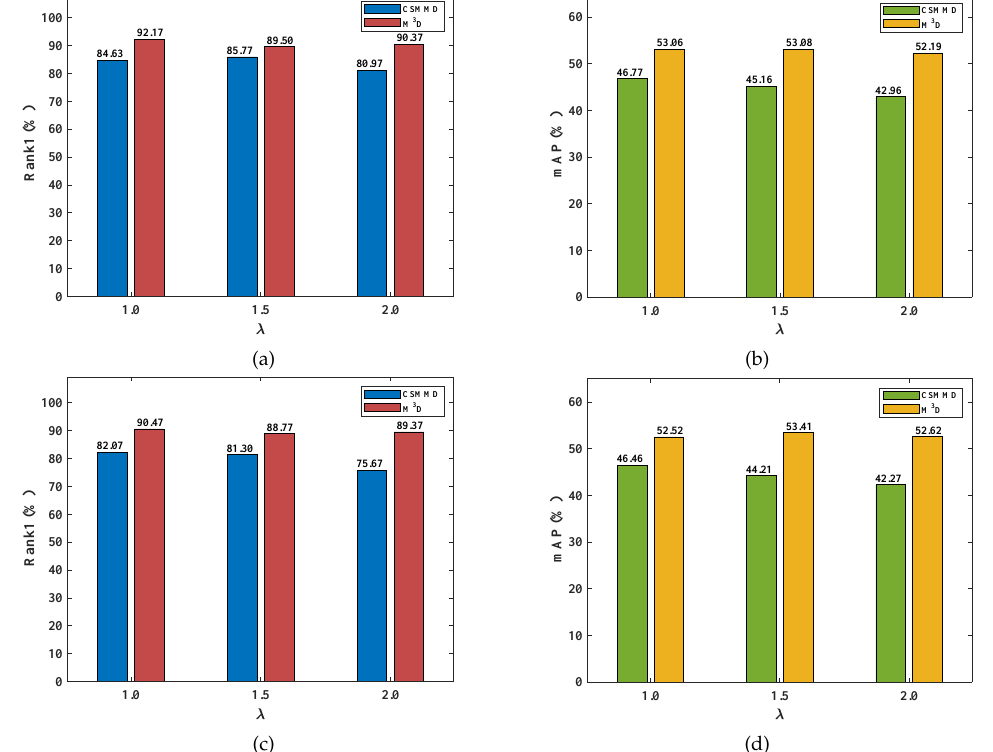
Figure 5. The comparison between our M 3 D and CSMMD [28] loss functions on the RGBNT201 dataset. ( a ) V2I Rank1, ( b ) V2I mAP, ( c ) I2V Rank1, and ( d ) I2V